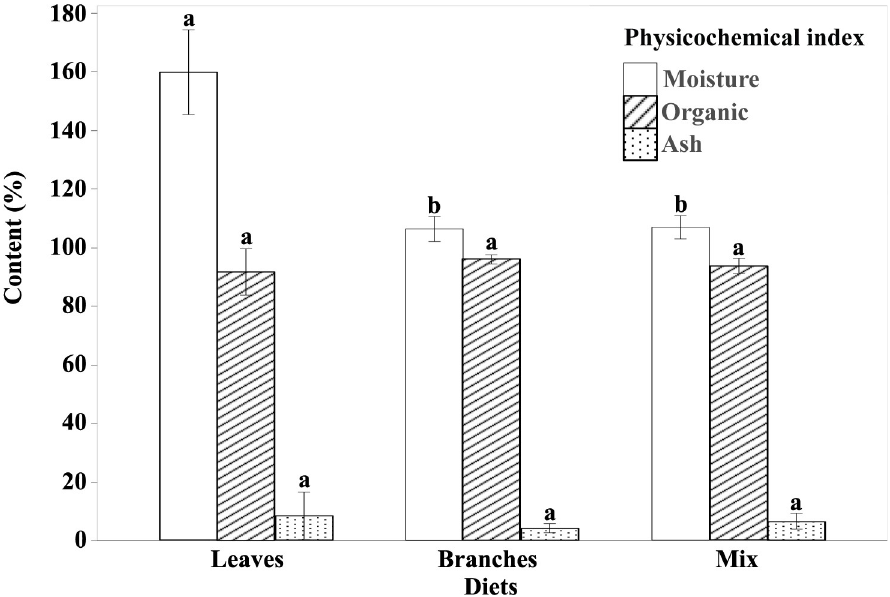
Fig 2. Comparison of the physicochemical indexes among fungus-combs built by different diets. The bar indicates mean ± SD (n = 9), bar labeled by different letters of the same index are significantly different as determined by Duncan’s new multiple range test (P <